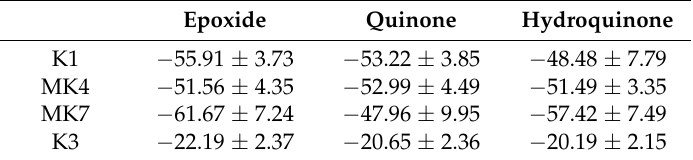
Table 1. Binding free energy (BFE) of vitamin K–VKORC1 complexes